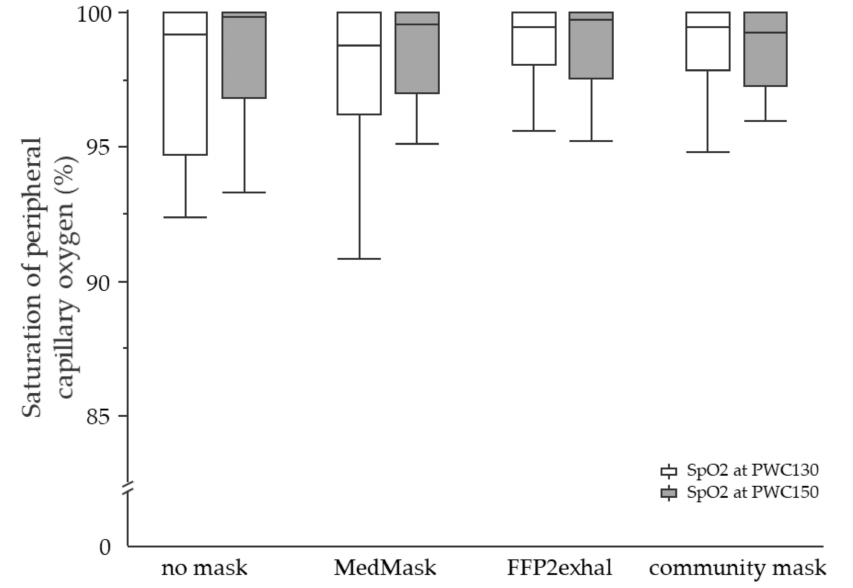
Figure 4. Saturation of peripheral capillary oxygen at the heart rate of 130 and 150 beats per minute using different face masks. Grey shaded boxplots represent oxygen saturation at PWC150. SpO2, saturation of peripheral capillary oxygen; PWC, physical working capacity; MedMask, medical face mask; FFP2exhal, filtering facepiece with exhalation